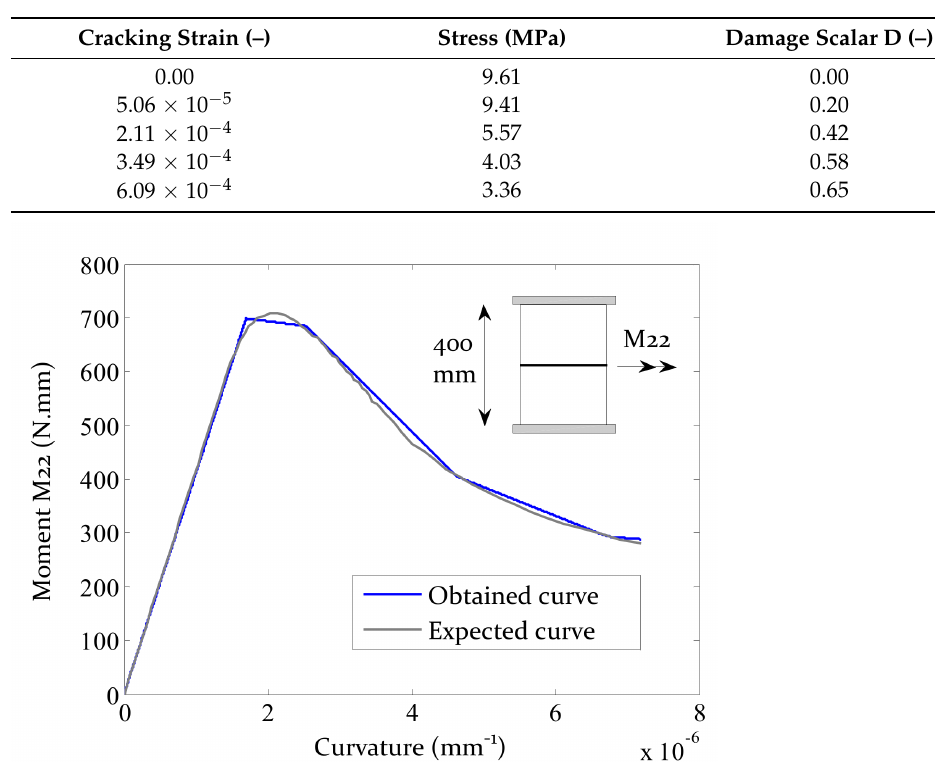
Table 2. Input stress–strain ( σ − ε ) curves for the FE trusses in the FE software (CDP model in ABAQUS).